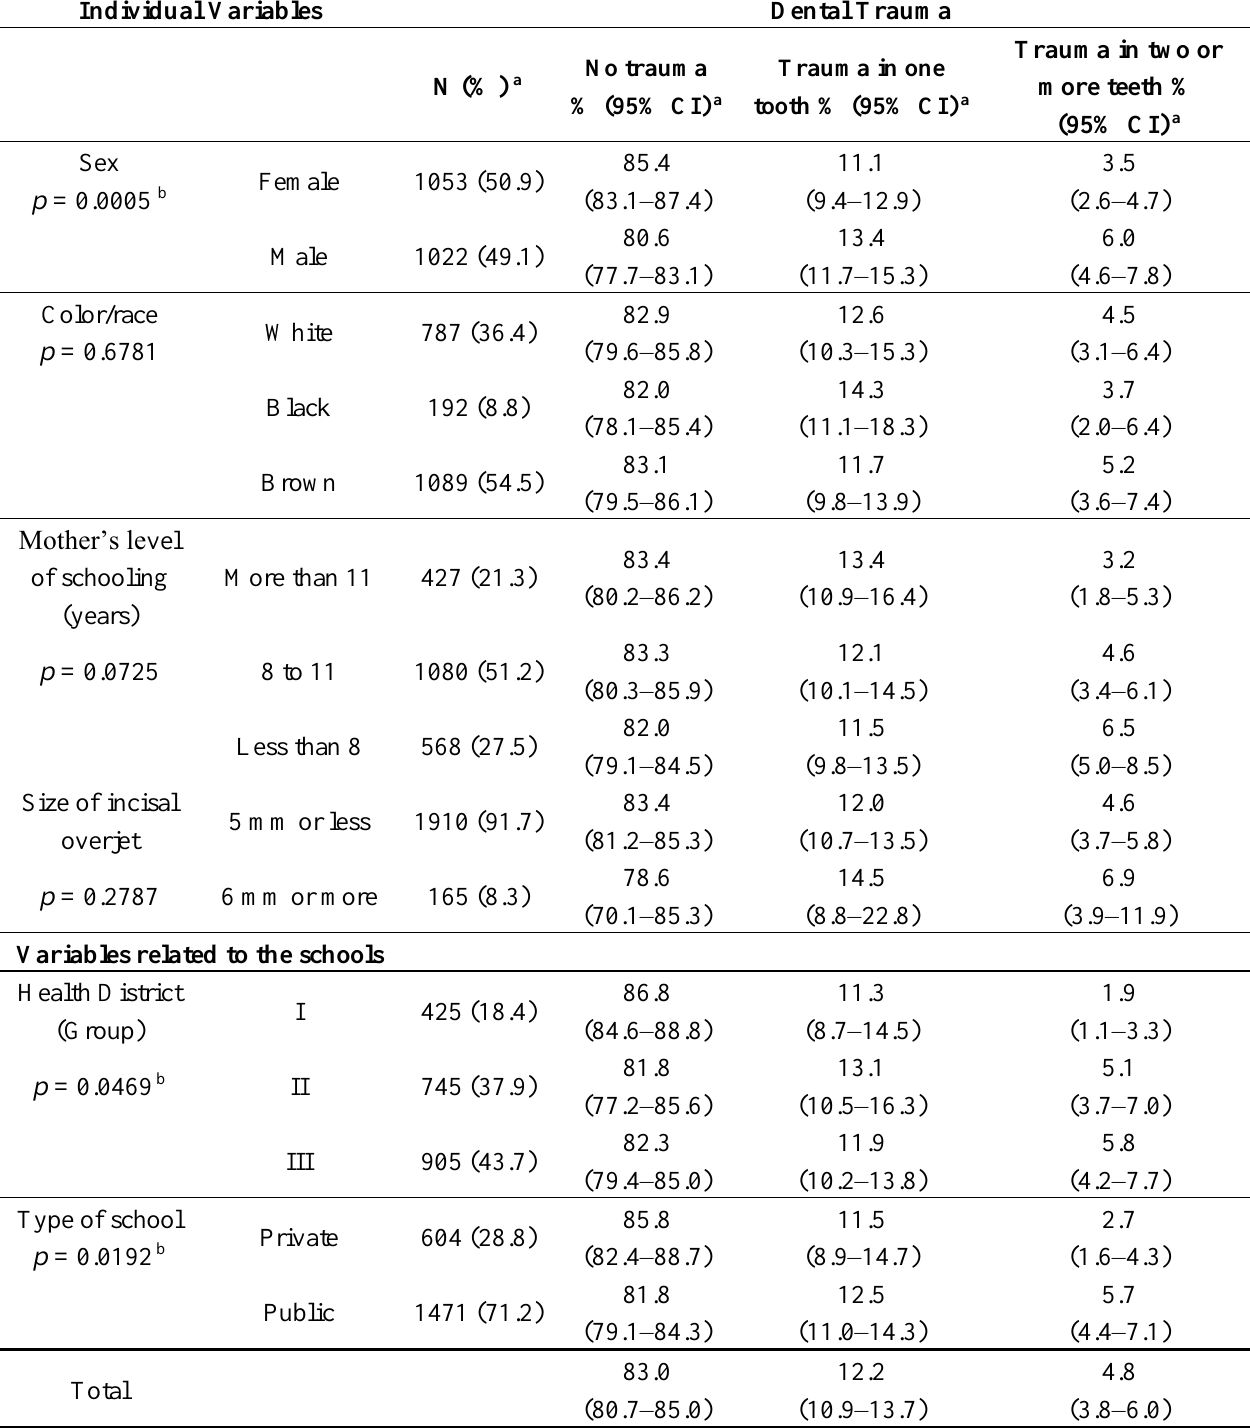
Table 1. Frequency distribution of untreated dental trauma according to independent